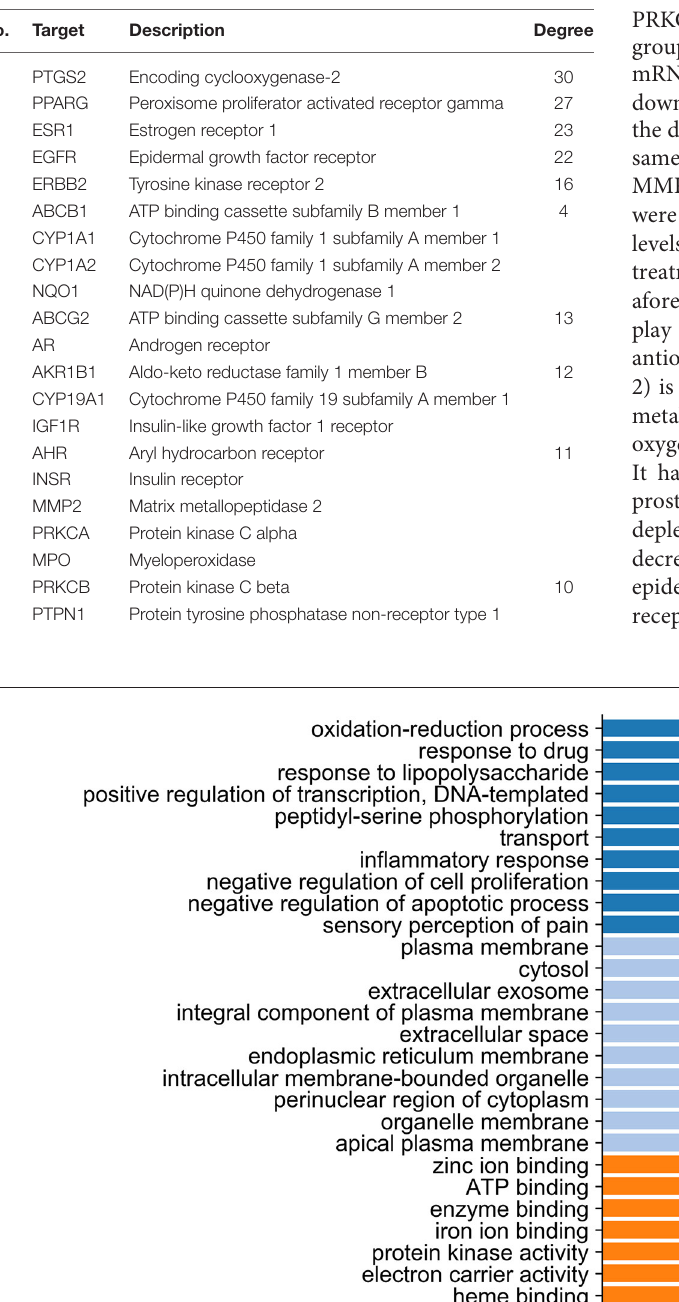
TABLE 2 | Top 20 hub genes of L. aureum antioxidant PPI network.